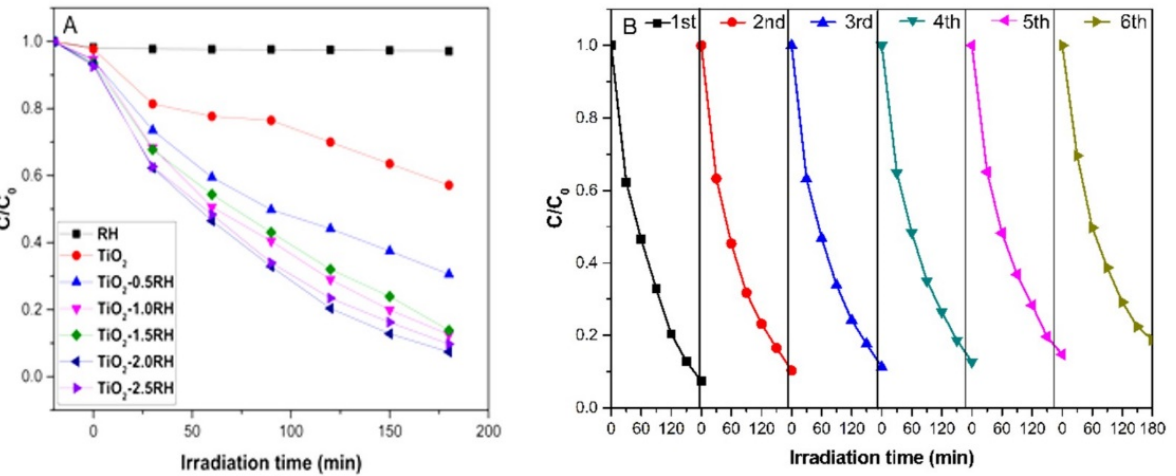
Figure 7. ( A ) Photodegradation kinetics of TiO 2 -RH towards 20 mg L − 1 MO solution in visible light. ( B ) Cycling photodegradation of MO by TiO 2 -2RH under visible light.